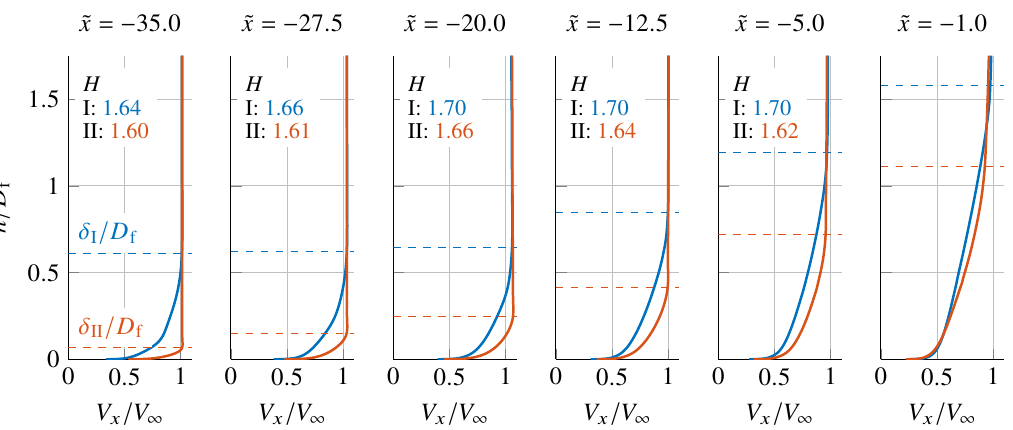
Figure 7. Boundary layer profiles: variations of V x / V ∞ with distance from surface h / D f . Horizontal dashed lines mark δ / D f the BL extent by stagnation pressure p 0 = 0.998 p 0, ∞